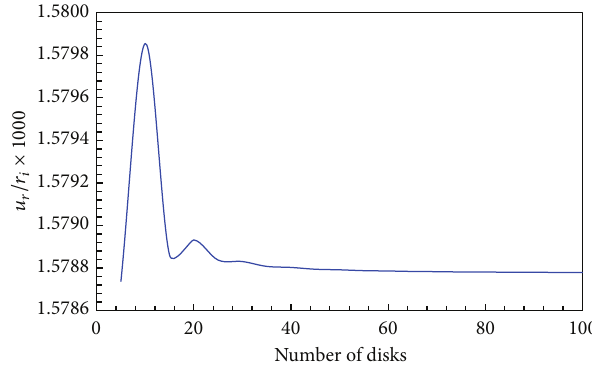
Figure 4: Effect of the number of disk layers on the radial